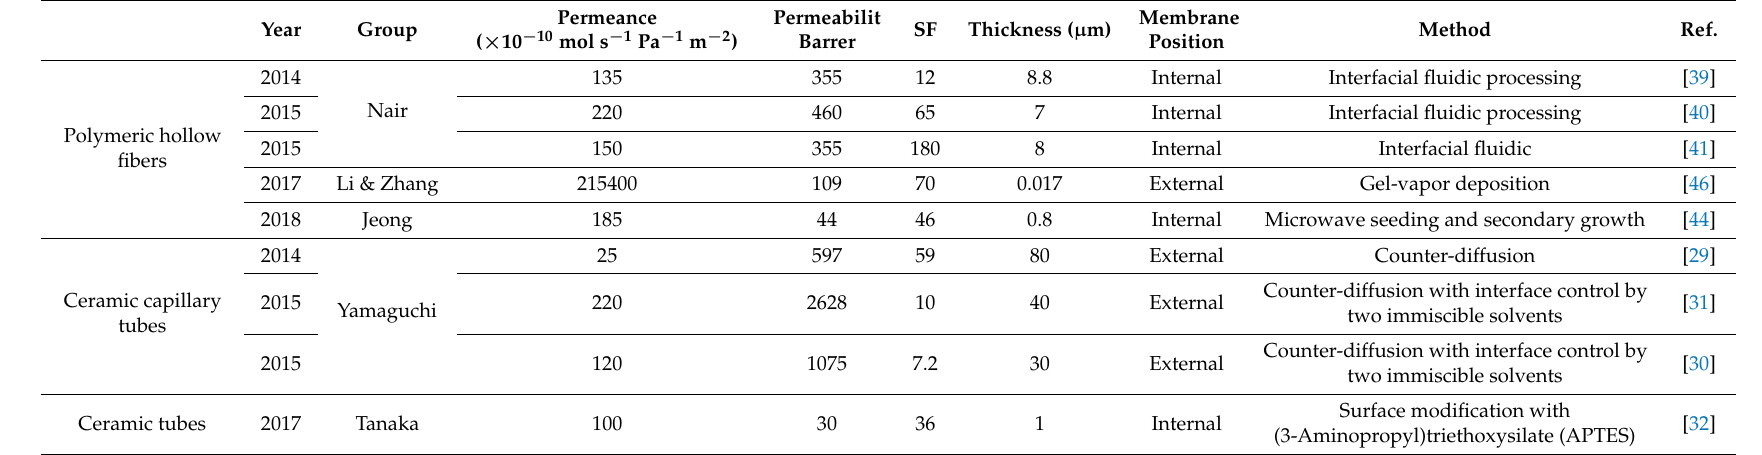
Table 1. Propylene-selective zeolitic imidazolate framework (ZIF-8) membranes on polymer hollow fibers and ceramic tubes. SF stands for separation